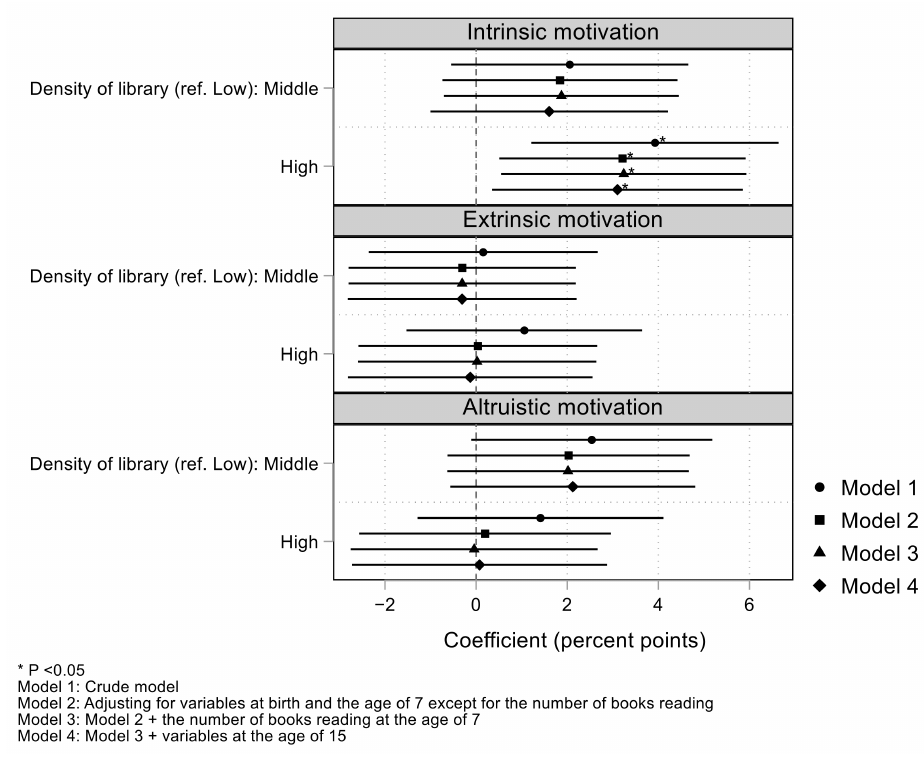
Figure 1. Association of libraries with motivational orientation for the desired occupation; multilevel linear probability model (level 1, individual: n = 12,184; level 2, municipality of residence wave 15: n = 1457; level 3, prefecture of residence wave 15: n =